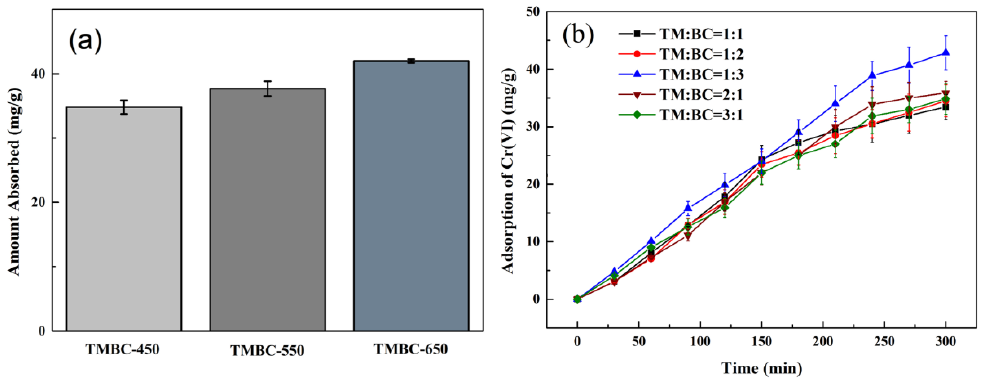
Figure 1. The adsorption of Cr (VI) by ( a ) different temperature TMBC and ( b ) different proportions of TMBC-650.